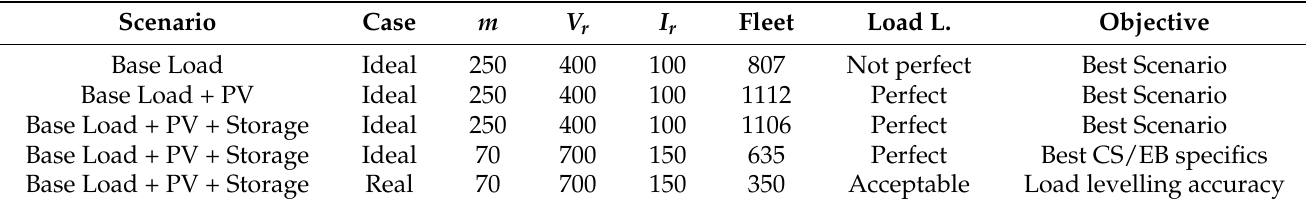
Table 6. Summary of the different scenarios’